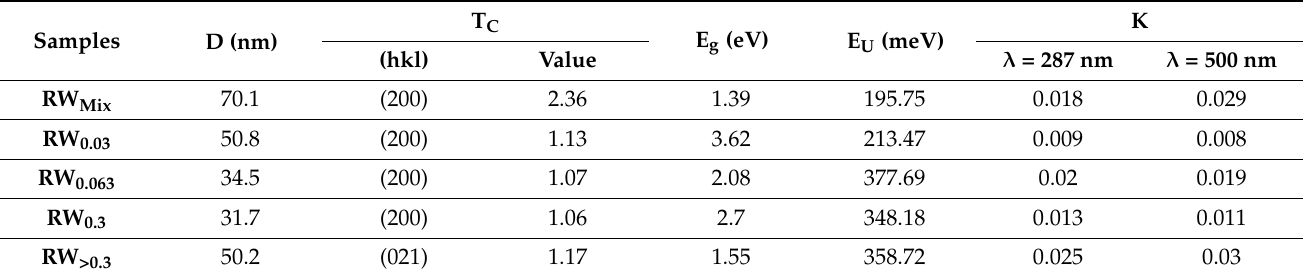
Table 1. The calculated parameters for RW as crystallite size (D), texture coefficient (T C ), energy gap (E g ), Urbach energy (E U ) and extinction coefficient